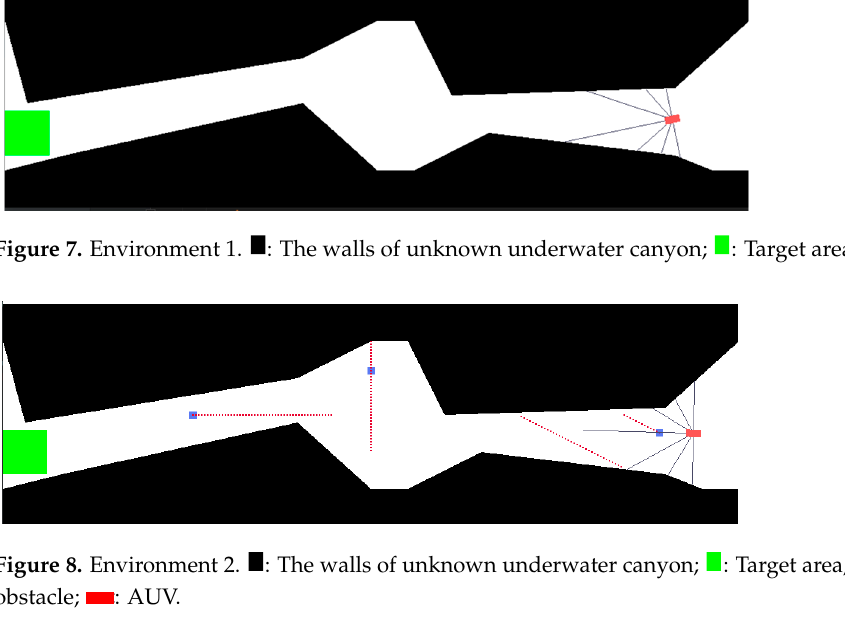
Figure 7. Environment 1. : The walls of unknown underwater canyon;